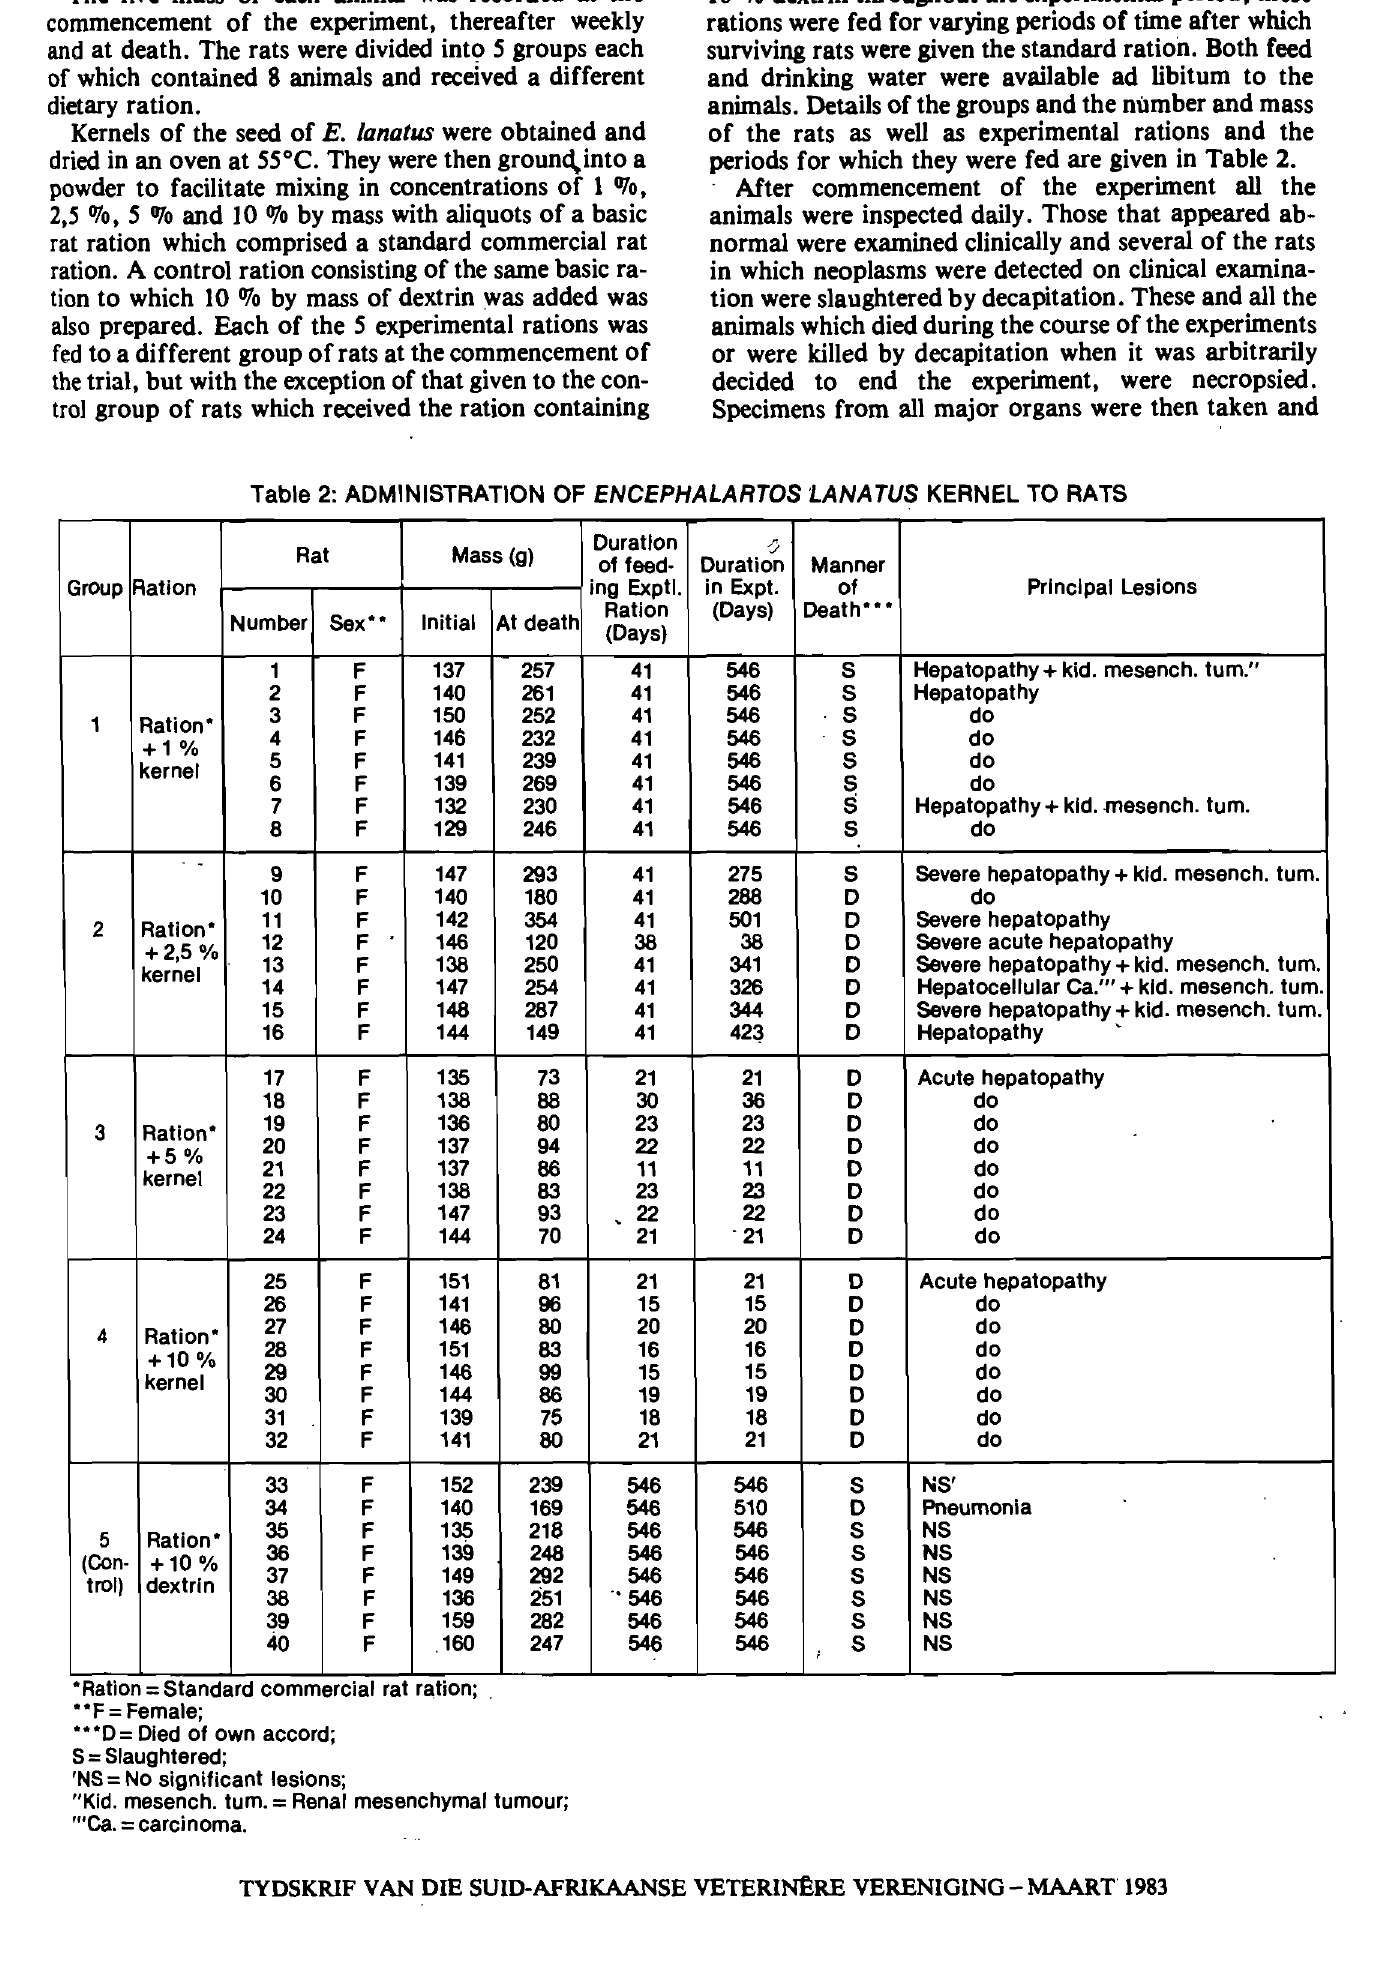
Table 2: ADMINISTRATION OF ENCEPHALARTOS LANATUS KERNEL TO